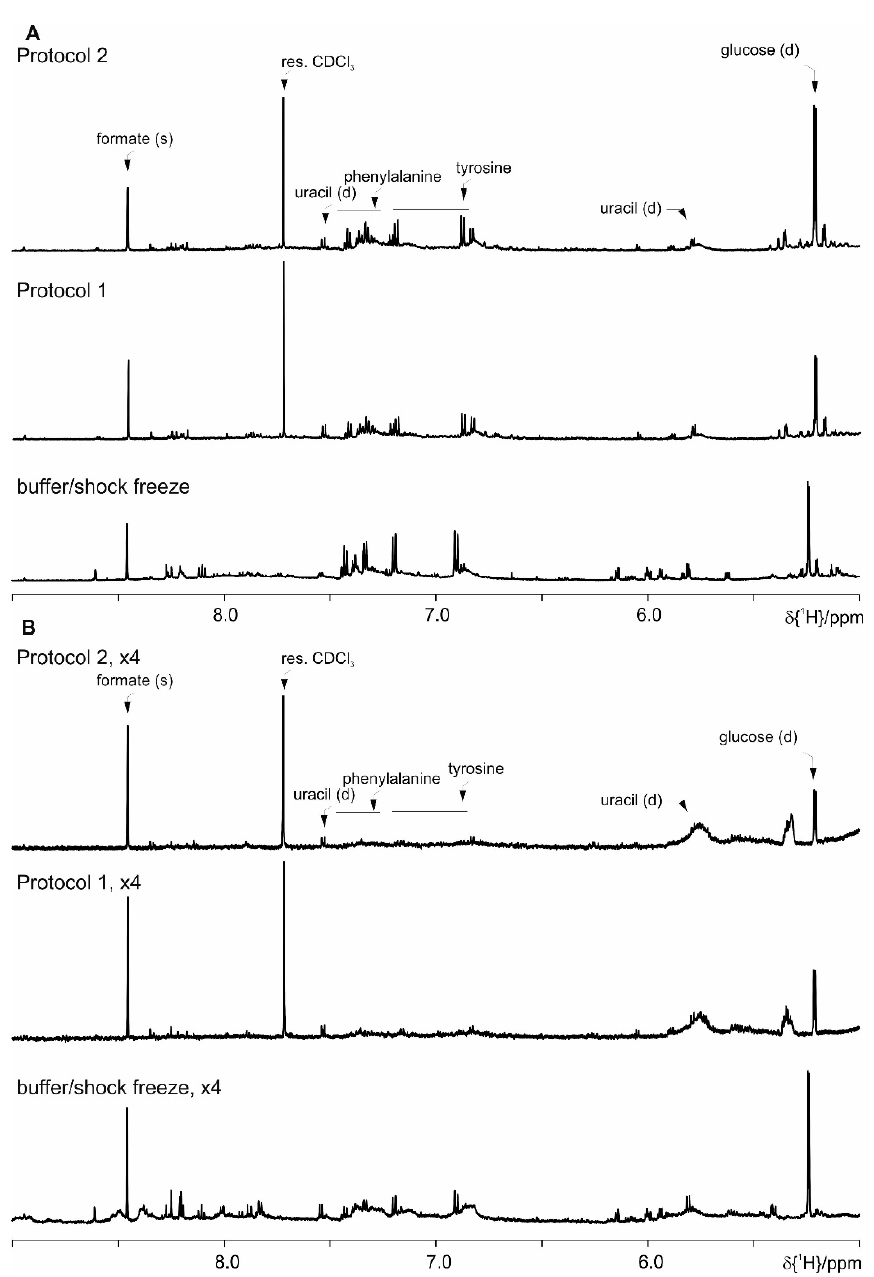
Figure 11. Comparison of Protocol 1 and 2 with the basic protocol with shock freeze: ( A ) feces of mice fed on a standard diet and ( B ) on HFD (the intensity is upscaled four times). For clarity only a selected spectral range (5.0 ppm till 9.0 ppm) of the proton NMR spectra is shown, where the most prominent metabolites are assigned.